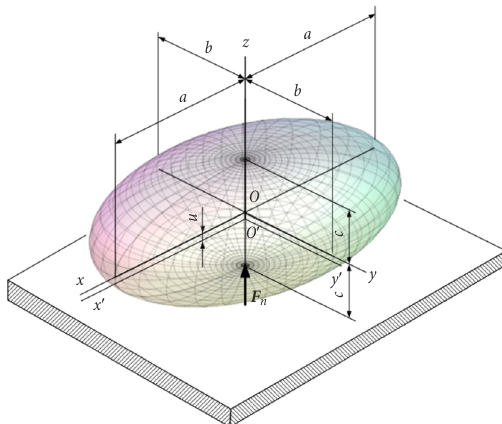
Fig. 8. Computational set up of the normal particle-plane